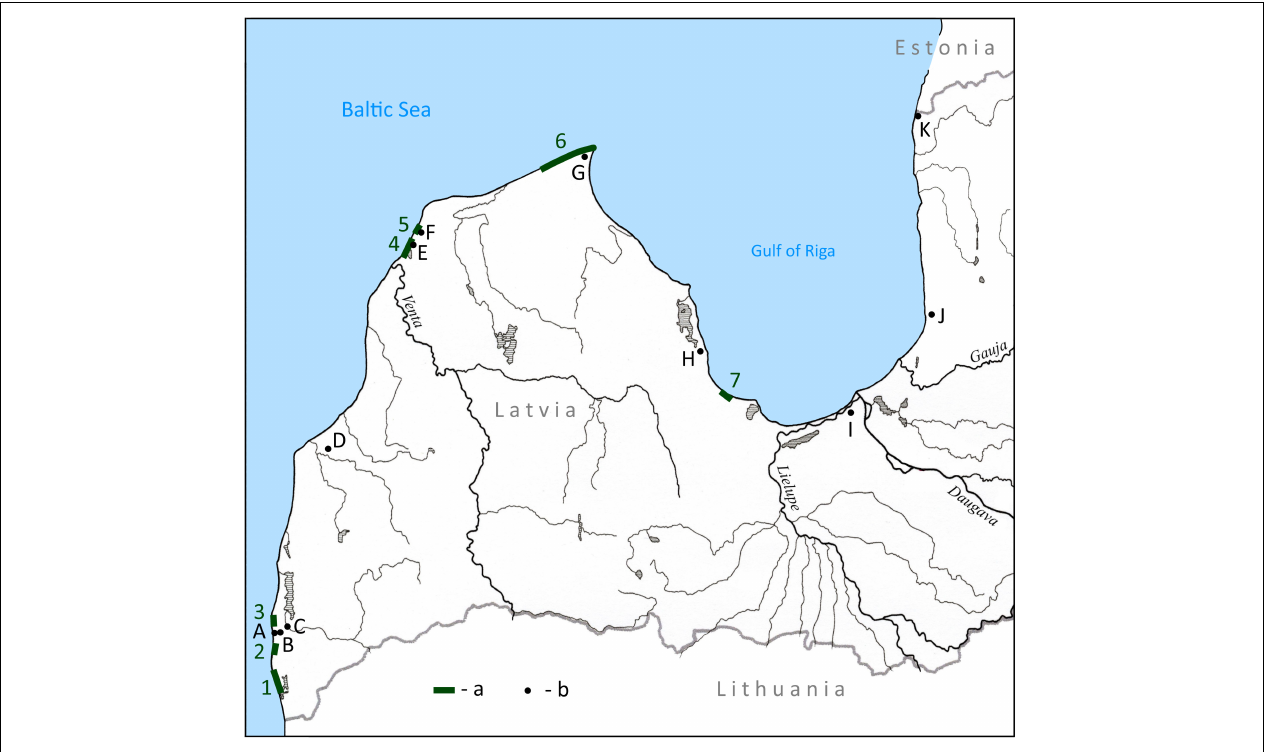
FIGURE 1 | Map of the coast of Latvia showing research sites mentioned in the text: (a) surveyed stretches of the coast; (b) sites providing the pine chronologies mentioned in the text.